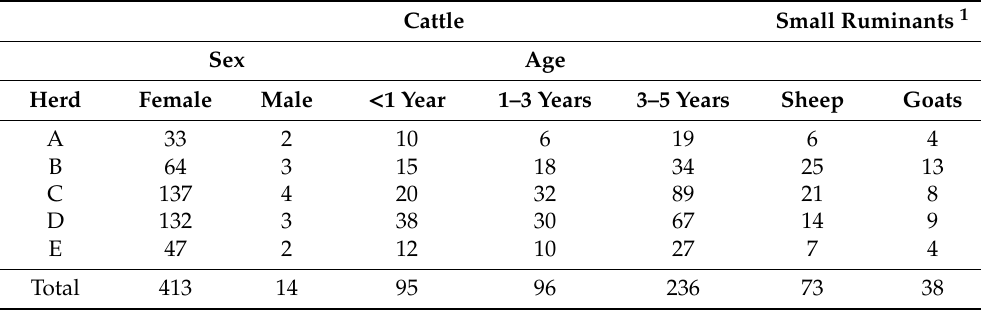
Table 1. Sex and age distribution in cattle herds and numbers of coreared small ruminants. Cattle Small Ruminants 1 Sex Age Herd Female Male < 1 Year 1–3 Years 3–5 Years Sheep Goats A 33 2 10 6 19 6